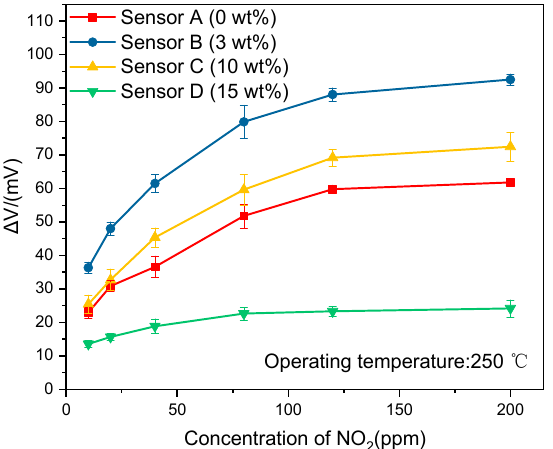
Figure 5. Response of the sensors doped with 0 wt%, 3 wt%, 10 wt% and 15 wt% to 10–200 ppm NO 2 at 250 °C.